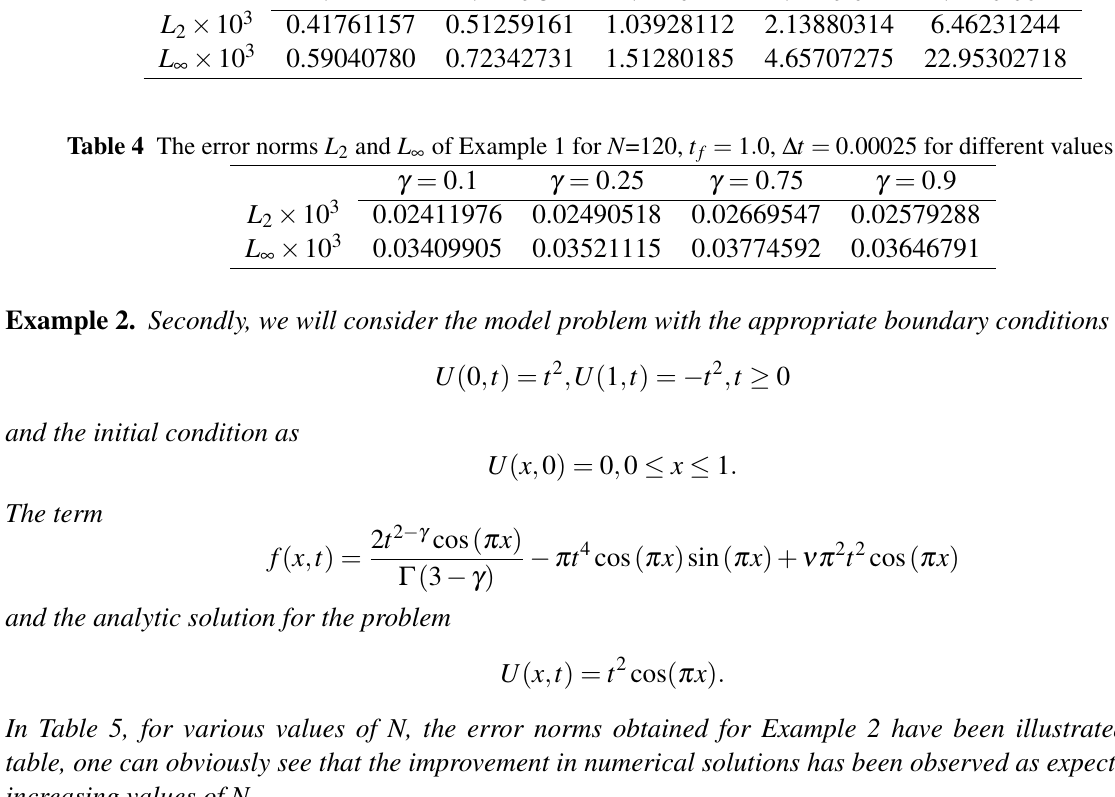
Fig. 1 A comparison of the analytic and approximate solutions using the Crank-Nicolson method for ν =1.0, N =40, γ =0.5 and ∆ t = 0.0025 at various values of final time Table 3 The error norms L 2 and L ∞ of Example 1 for γ =0.5, ∆ t =0.00025, t f =1.0, N =40 and various values of ν ν = 1 ν = 0 . 5 ν = 0 . 1 ν = 0 . 01 ν = 0 . 001